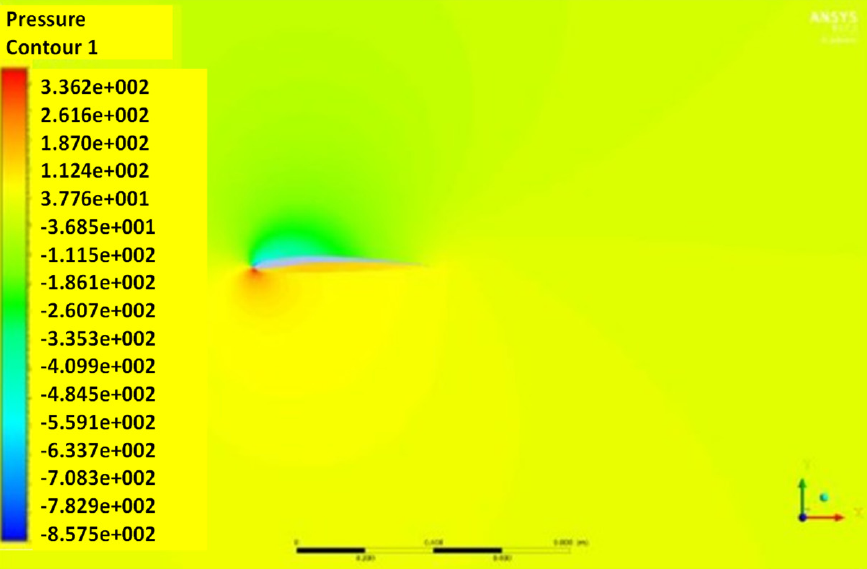
Figure 21. Pressure contour of the NACA2410 to NACA8410 transition at AoA 5 ◦ .